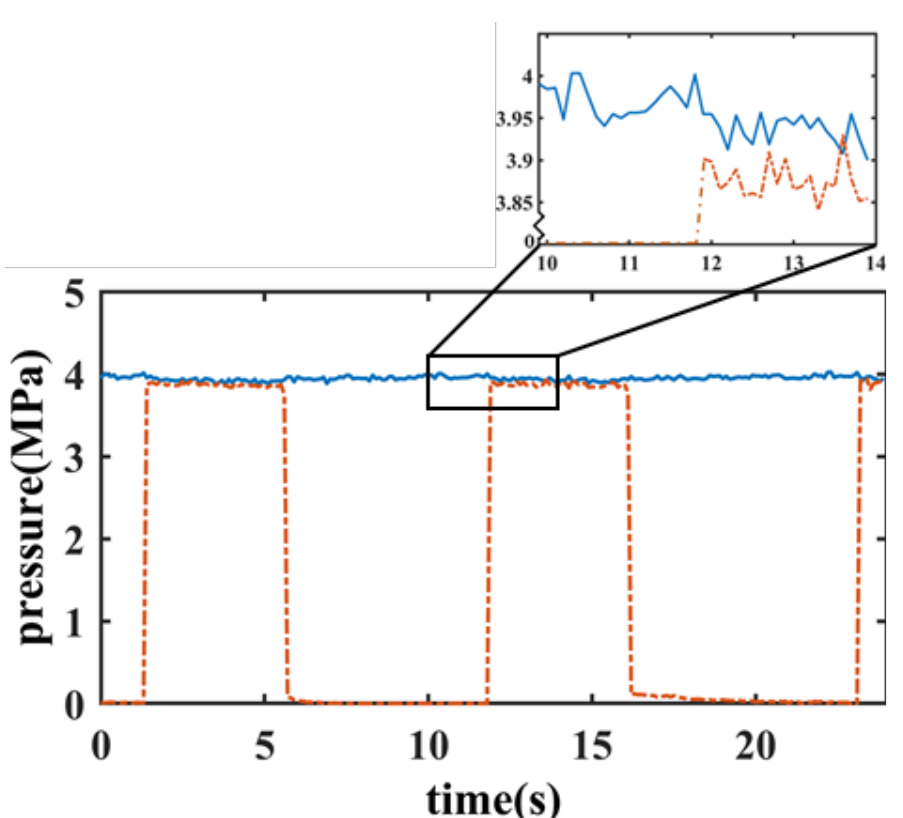
Figure 8. Time histories of pressure transmitters 17 (a) (solid line) and 17 (b) (dash-dotted line). The average values of output power and power fluctuation index under different trigger pressure conditions are shown in Figure 9.